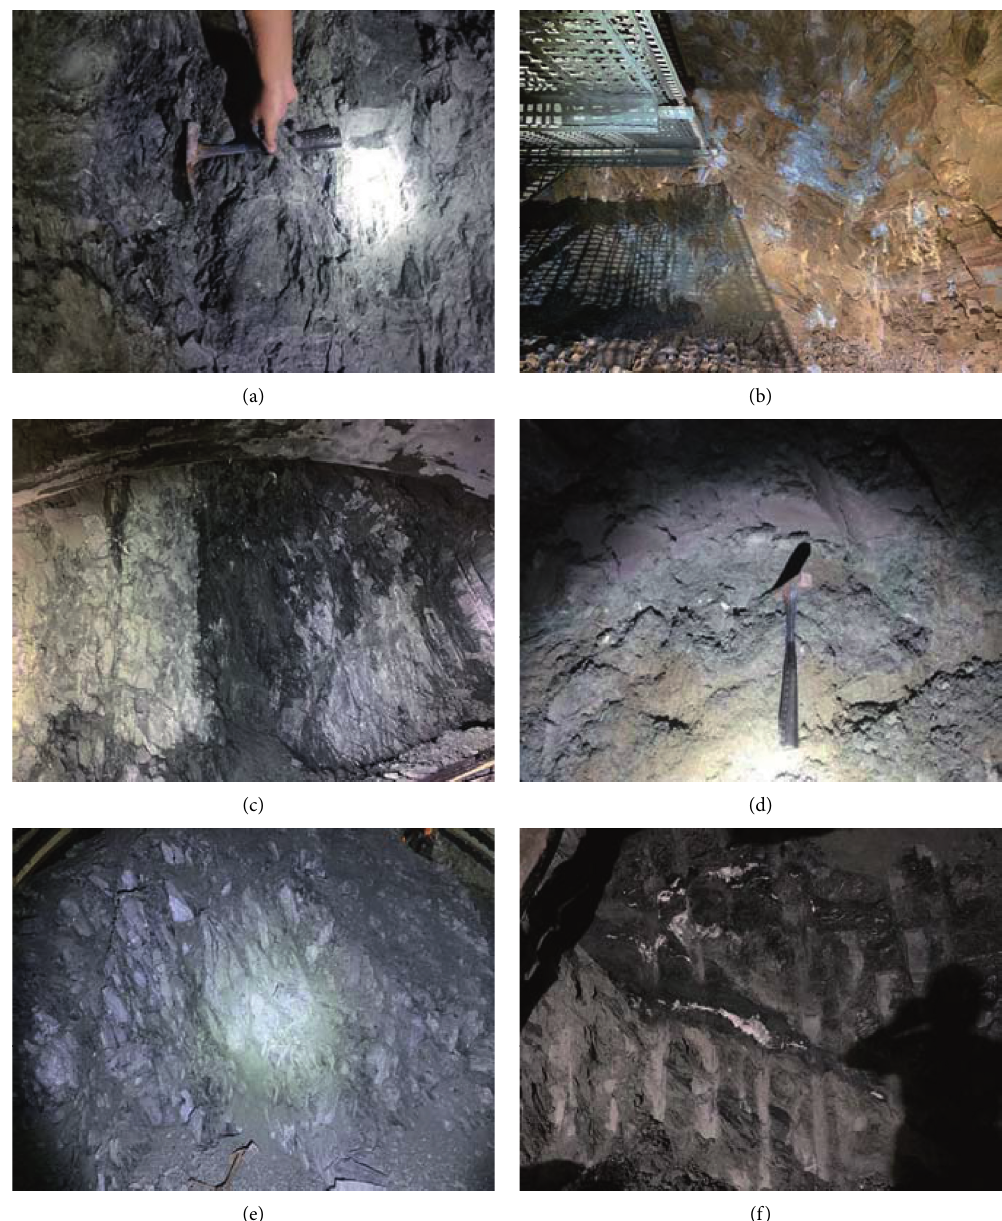
Figure 3: Talus-like rock mass encountered during the tunnel excavation: (a) slate and weak interlayer filled with mudstone at Z5K62+936; (b) slate and weak interlayer filled with weathered rock and soft soil at Z5K63 +966; (c) mixture of slate, limestone, and carbonaceous mudstone at Z5K64+455; (d) twisted layers composited by slate and limestone at K62 +860; (e) isolated rock blocks cut by interlayers filled with weak mudstone at K64 +530; (f) limestone with carbonaceous mudstone interlayer at K64